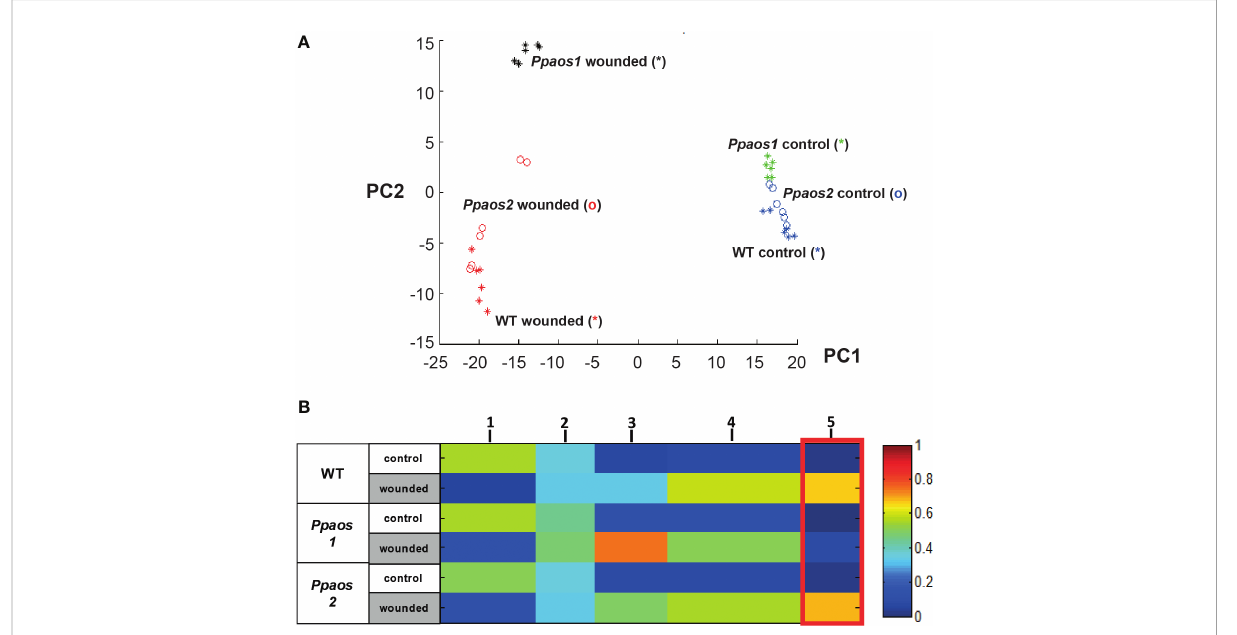
FIGURE 1 Metabolite fi ngerprinting analysis of a wounding experiment for P. patens WT, Ppaos1 and Ppaos2 KO-mutants. Moss cultures were grown on agar-plates at long-day conditions (16 h day/24°C to 8 h night/18°C cycle), wounded and deep frozen 30 min past wounding. After two-phase extraction, the samples were analyzed by UPLC-HR-MS. The MarVis toolbox was used for data mining (Kaever et al., 2015). 800 reliable features (FDR < 10 -4 ) from two independent experiments (including data of positive and negative ionization mode of the polar and non-polar extraction phase) were used for clustering by PCA (A) and one-dimensional-self organizing map (1D-SOM) (B) . Ppaos2 and WT moss are indistinguishable on an overall metabolite level, whereas Ppaos1 shows a unique chemotype after wounding. Three parallel cultures of each genotype and two extractions of each culture were analyzed for the two independent experiments. The heat map colors represent average intensity values according to the color map on the right-hand side. The width of each cluster is proportional to the number of features assigned to this